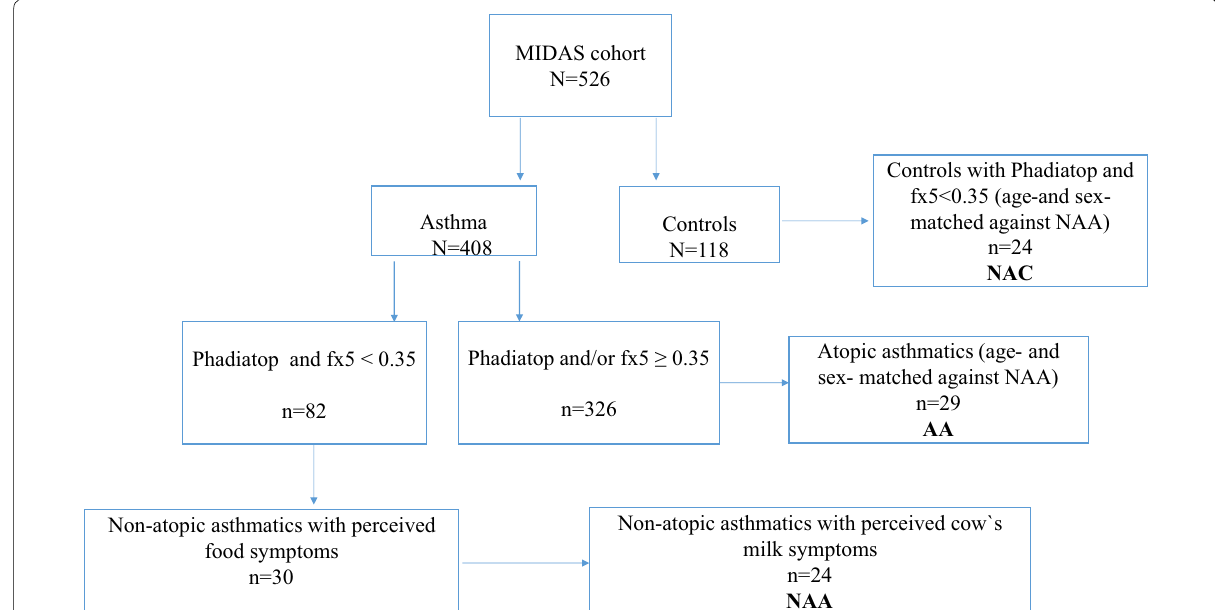
Fig. 1 Description of the included study groups as regards IgE sensitization and perceived food hypersensitivity. IgE concentrations in kU A